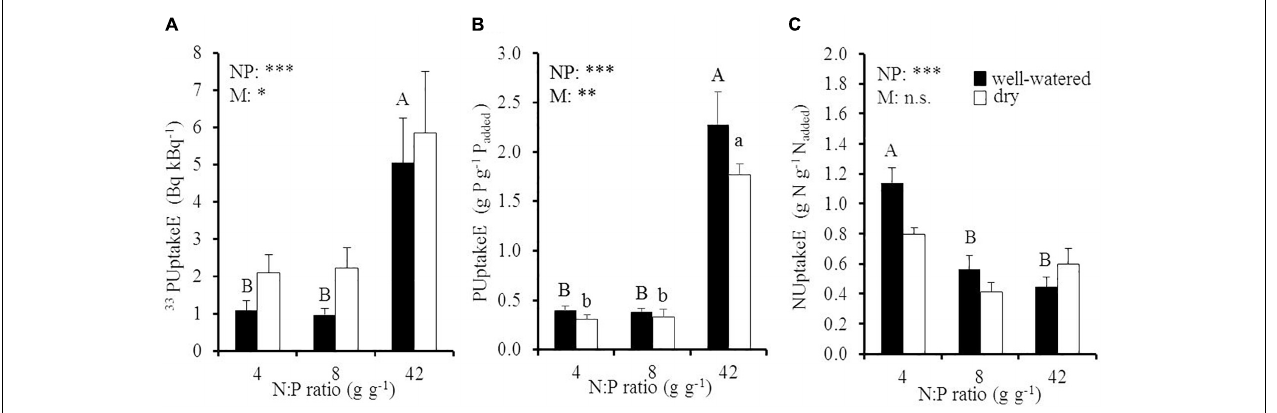
FIGURE 3 | (A) Instantaneous 33 P uptake efficiency ( 33 PUptakeE), (B) long-term P uptake efficiency (PUptakeE), and (C) N uptake efficiency (NUptakeE) of young Palestine oak ( Quercus calliprinos ) trees grown at increasing soil N:P ratio and decreasing soil moisture in a climate chamber. Shown are means and standard errors for replicate saplings ( n = 48 for PUptakeE; n = 24 for 33 PUptakeE and NUptakeE). The results of two-way ANOVAs on the significance of the effect of the soil N:P ratio (NP) or soil moisture (M) are indicated by asterisks ( ∗∗∗ , ∗∗ , and ∗ for p ≤ 0.001, 0.01, and 0.05; n.s., not significant). Significant differences at p ≤ 0.05 between soil N:P ratios are indicated for well-watered soil by different upper-case letters and for dry soil by different lower-case letters.